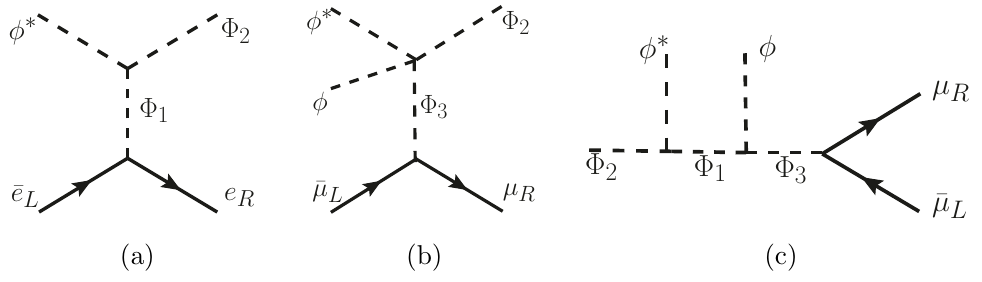
Figure 3 . The relevant Feynman diagrams for generating EFT Lagrangian. The (cid:12)gure (a) is responsible for (cid:30) (cid:3) (cid:22) L e He R + H:c: , while (b) and (c) are responsible for (cid:30) (cid:3) (cid:30) ((cid:22) L (cid:22) H(cid:22) R + H:c: